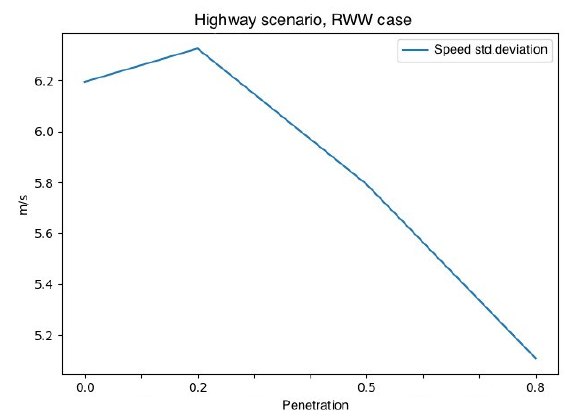
Figure 10. The standard deviation of the speed on a highway with RWW deployed.